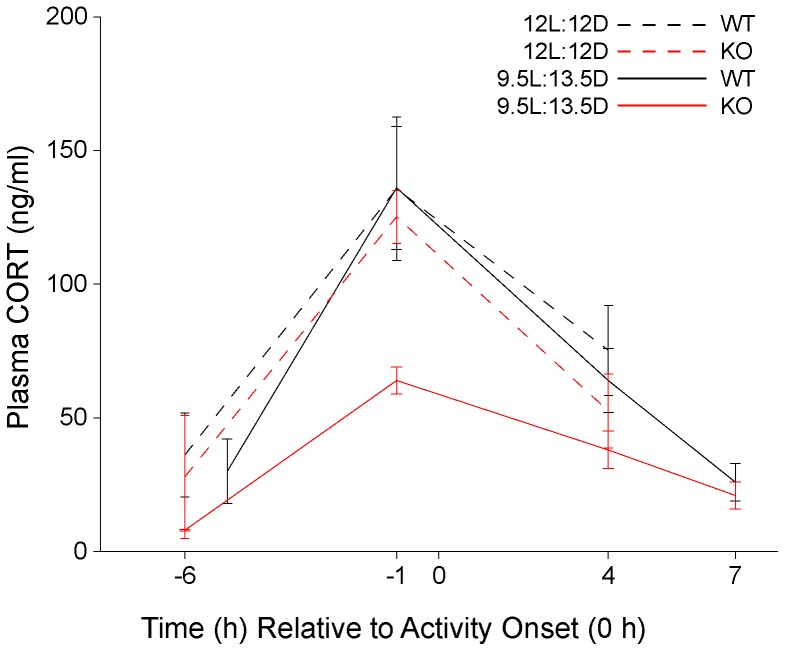
Compilation of plasma CORT data from Experiments 1 & 2 normalized relative to activity onsets.Peak CORT values at 1 h before activity onset of wild type (WT) mice maintained under 12L:12D and 9.5L:13.5D and 5-HT1B knockout (KO) mice maintained under 12L:12D conditions were similar and significantly greater than −1 h CORT values of KO mice maintained under 9.5L:13.5 D conditions (p<0.01).